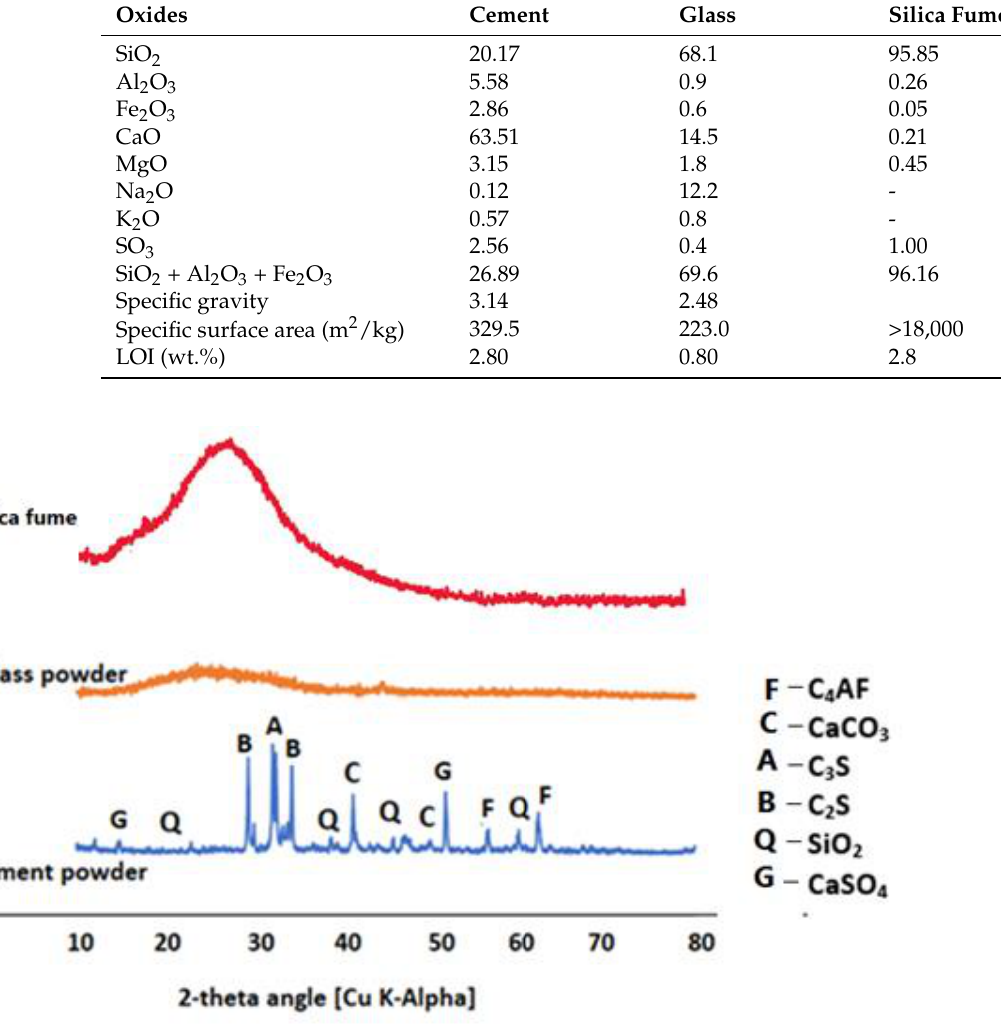
Figure 2. XRD diffractogram of the glass waste and cement powder.